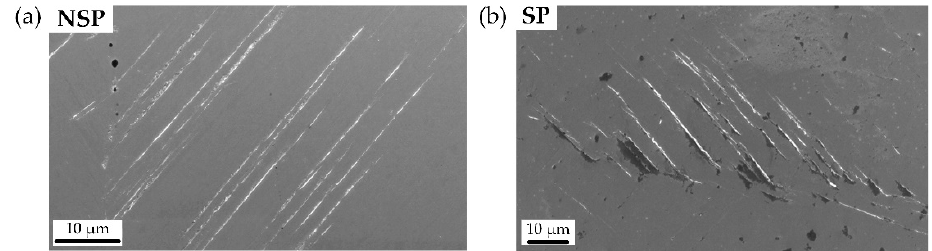
Figure 5. SEM images of slip bands locally oriented in parallel in an ( a ) NSP sample, loaded at ∆σ /2 = 680 MPa, recorded after 90,000 loading cycles and ( b ) an SP sample, loaded at ∆σ /2 = 700 MPa, recorded after 642,030 loading cycles.